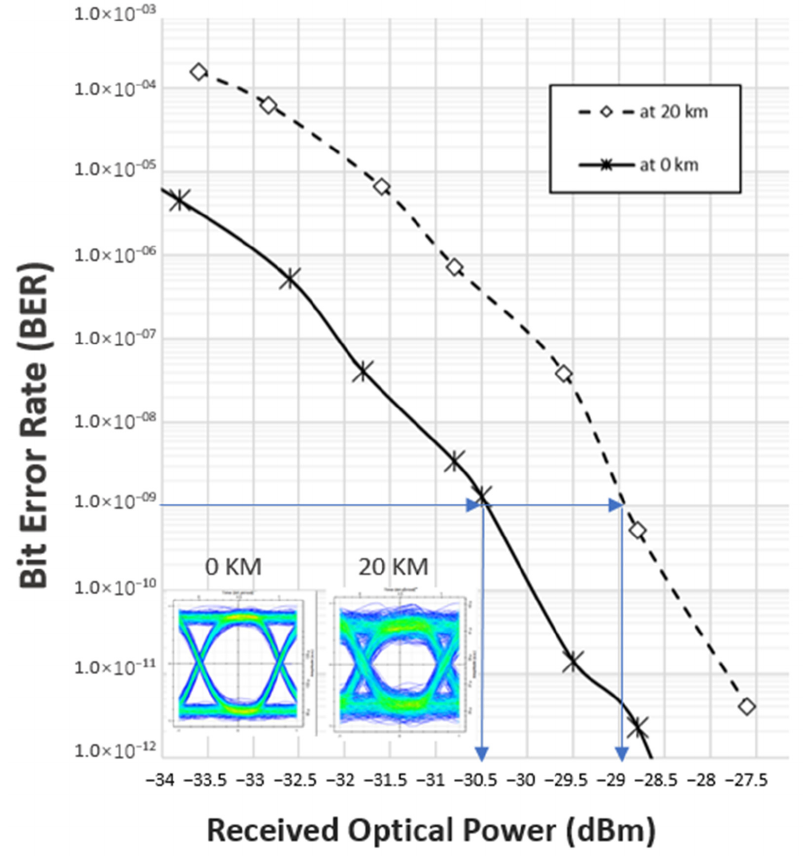
Figure 6. BER vs. the received optical power (ROP) at 0 km and 20 km fiber length.